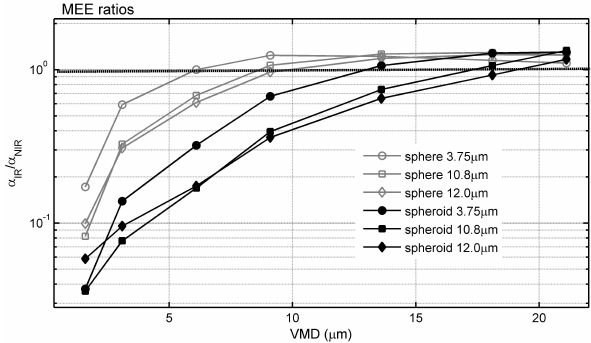
Fig. 10. Log scale of MEE ratios ( α IR /α NIR ) versus VMD for the Hess/OPAC parameterization using spheres and oblate spheroids with aspect ratio 1.8. The IR wavelengths (legend) are the centers of AVHRR channels 3, 4, and 5, respectively. Refer to Table